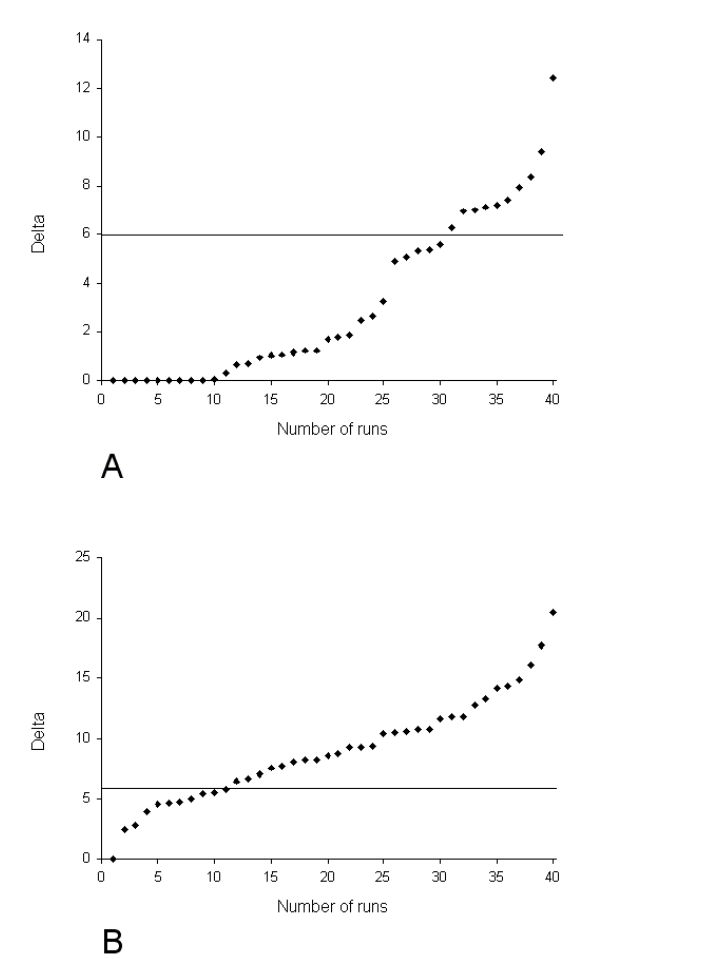
Figure 7: Evidence for positive selection when using 10 randomly chosen non-HEW Coffea pu- tative S-RNase sequences. Delta - twice the difference of the log-likelihoods of the models being compared. A - M2 (Positive Selection) vs M1 (Nearly Neutral); B - M8 (beta) vs M7 (beta & ω > 1 ). The line indicates the level above which the difference in the log-likelihoods is